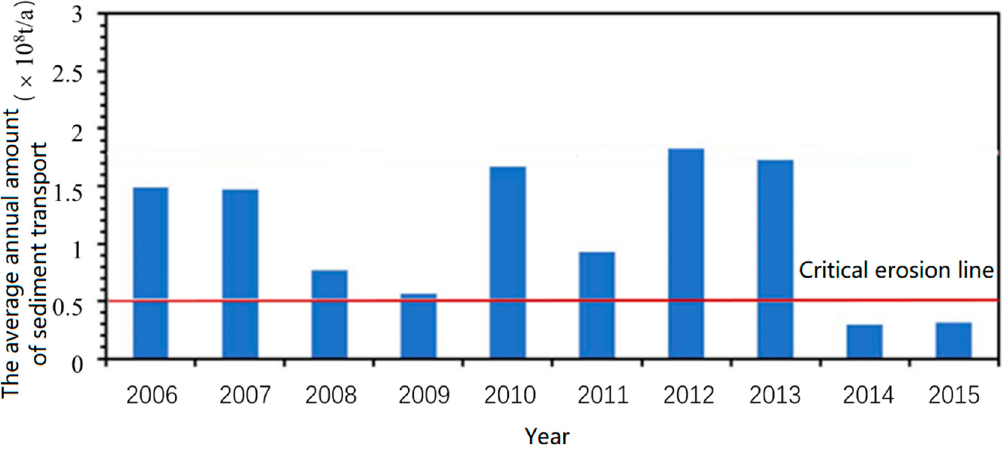
Figure 10. Annual erosion and deposition at the Yellow River's subaqueous delta (data from the Yangtze River Sediment Bulletin).